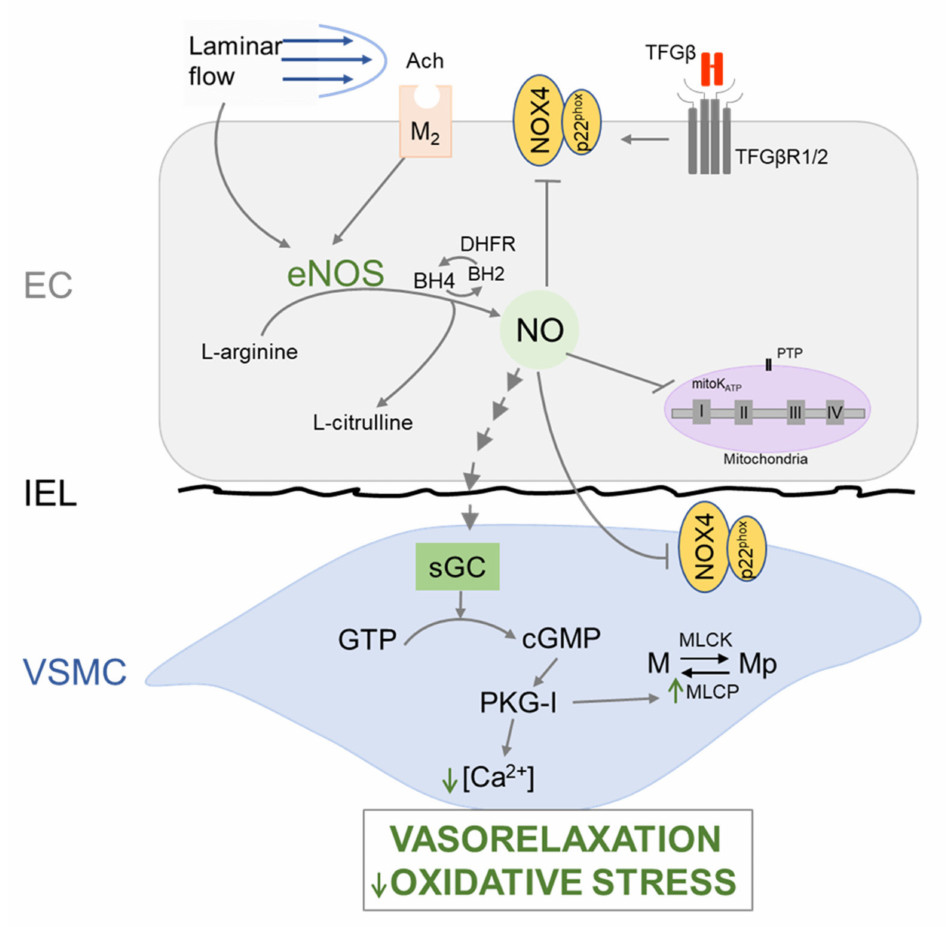
Figure 3. Nitric oxide (NO)/cGMP/PKG-I signaling pathway. In response to humoral or mechanical stimuli (e.g., Ach or shear stress), NO is synthesized in EC from L-arginine by activated form of eNOS. NO diffuses to neighboring SMC, where it activates soluble guanylate cyclase (sGC), which subsequently increases the intracellular production of cGMP from GTP. cGMP activates cGMP- dependent protein kinase I (PKG-I), which reduces intracellular Ca 2+ concentration, and activates myosin light chain phosphatase (MLCP) to dephosphorylate myosin light chain (M), leading to SMC vasorelaxation. EC-derived NO can buffer ROS and prevent oxidative stress by inhibiting NOX activation in EC and SMC. It may also inhibit mitochondrial K ATP channel (mitoK ATP ) opening,